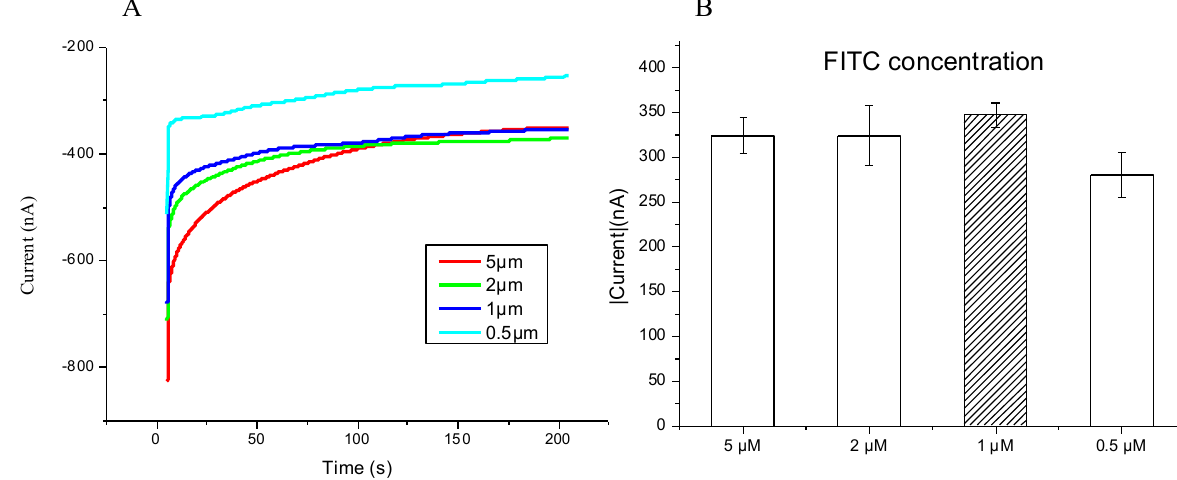
Figure 3. Observations of a range of time periods (15 min, 30 min, 1 h, and 2 h), the modified surface of SPCE reacted with the 5 µ m biotinylated capture probe at room temperature, and the currents measured by ( A ) CV and ( B ) biotinylated capture probe. The 1 h reaction time showed the best reduction potential value. The bar chart also shows the triple examinations with confidence intervals.